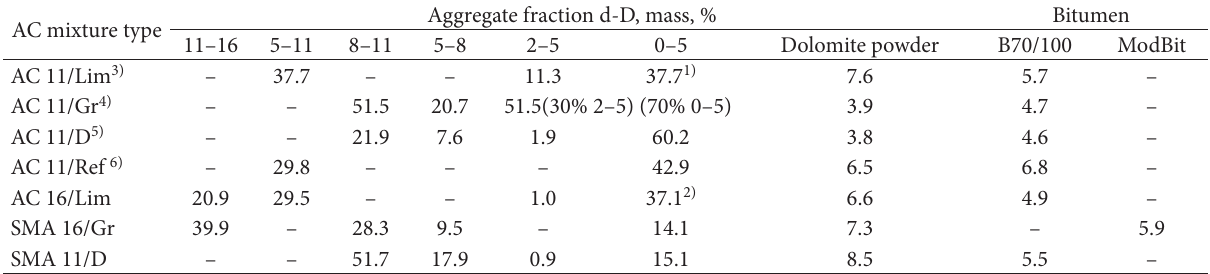
Table 4. Compositions of the dense graded AC mixture and SMA